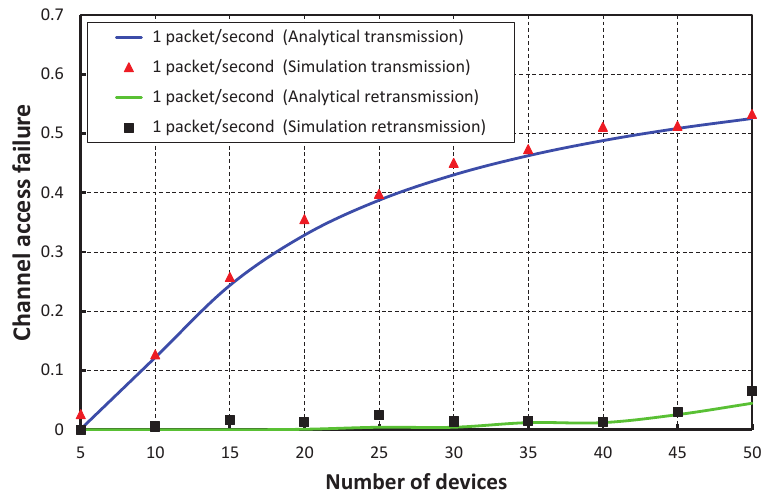
Figure 9. Validation of our proposed scheme for channel access failure for different numbers of devices.